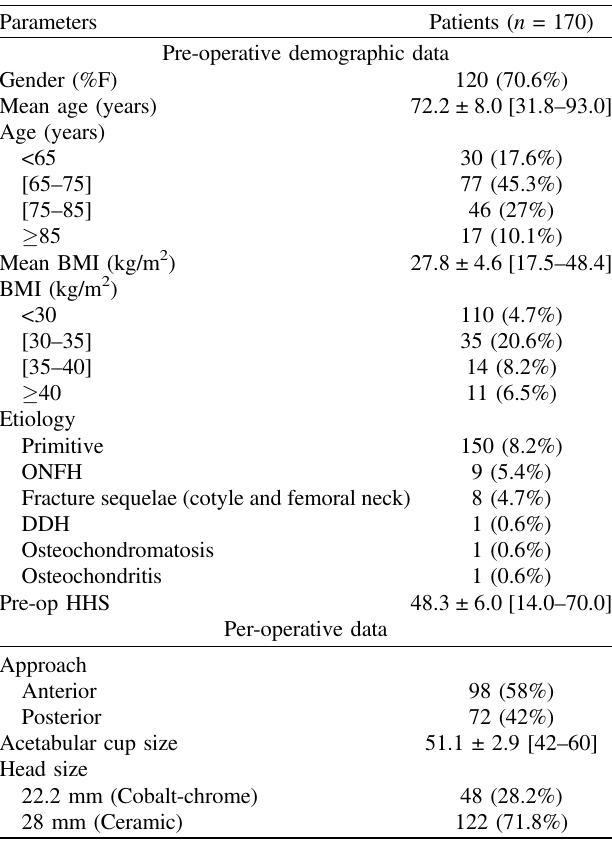
Table 1. Pre-operative demographic data and per-operative data.